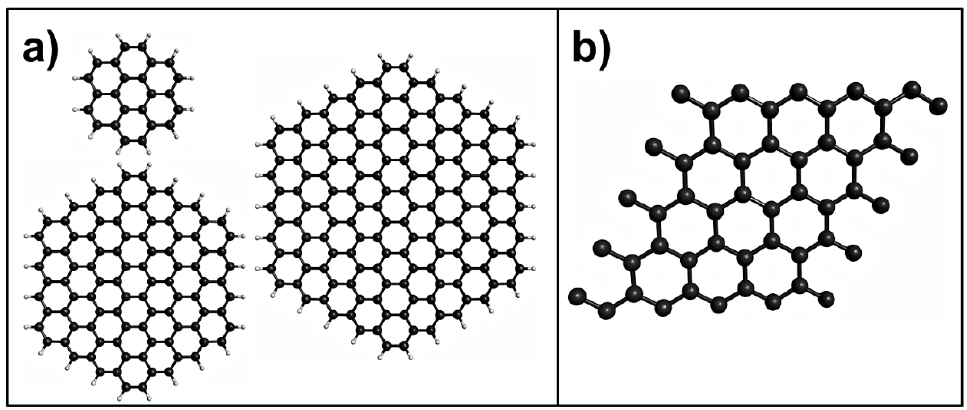
Figure 2. Models of graphene used for the density functional theory (DFT) calculations: ( a ) aromatic molecules, ( b ) graphene supercell. Black and gray spheres represent C and H atoms, respectively.